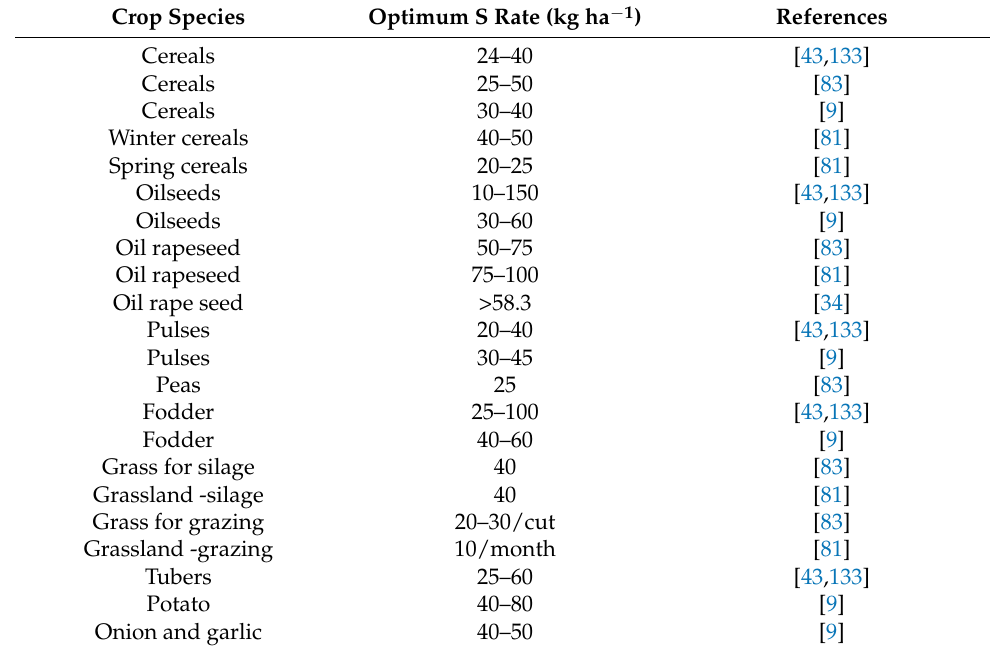
Table 2. Recommended optimum S application rates in selected crop species. Crop